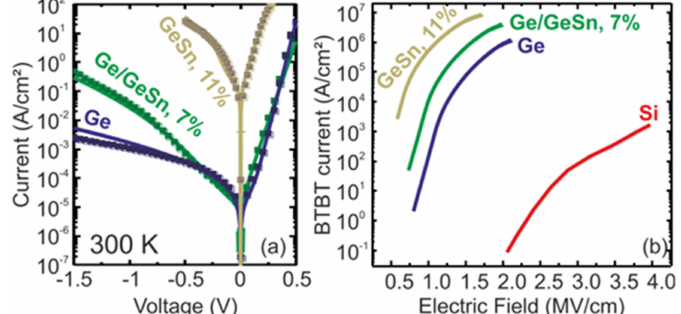
Figure 38. Process flow for Ge/GeSn vertical heterojunction pTFETs. Reproduced with permission from [99], IEEE, 2017. Figure 39. ( a ) RT current–voltage characteristics for GeSn p-i-n diode; ( b ) extracted BTBT current vs. electric field. Reproduced with permission from [99], IEEE, 2017.